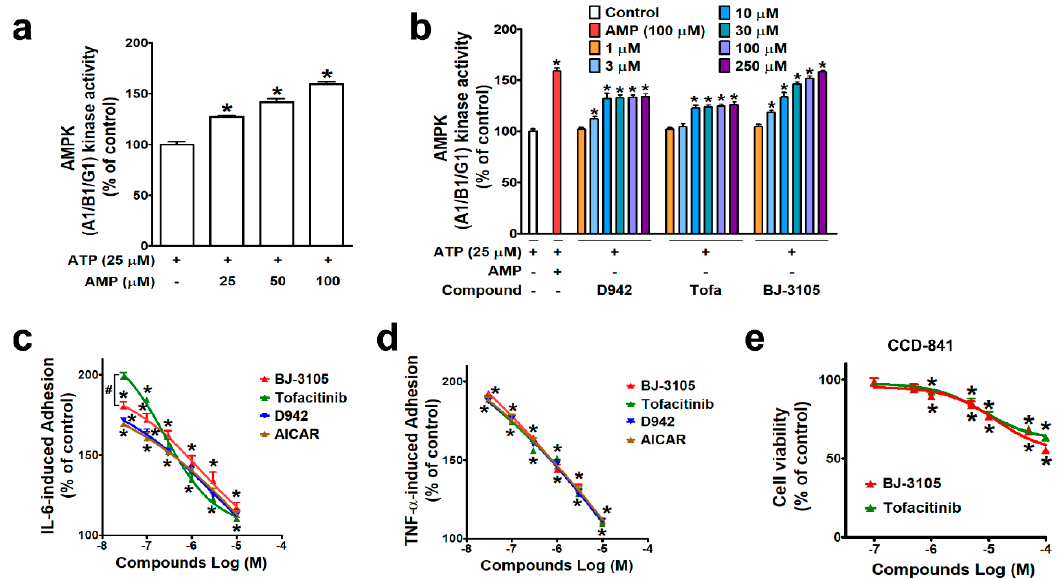
Figure 1. Comparison of the effects of BJ-3105 and tofacitinib on AMPK activity and cytokine-induced adhesion of monocytic cells to colonic epithelial cells. ( a,b ) AMPK enzyme activity at an ATP